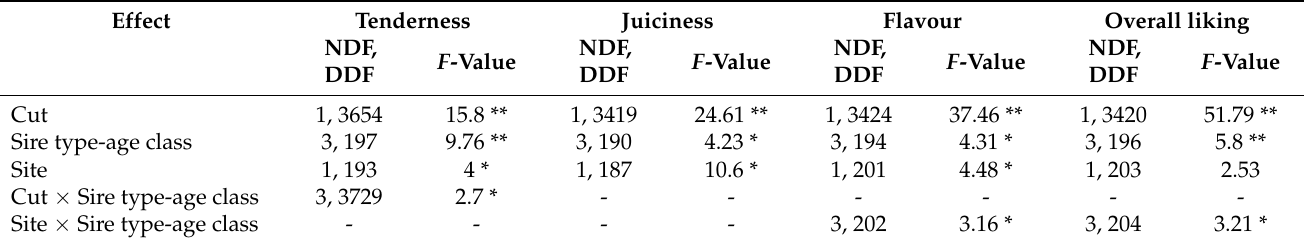
Table 3. F -values, NDF and DDF for base linear mixed effects models for predicted eating quality scores of tenderness, juiciness, liking of flavour and overall liking.